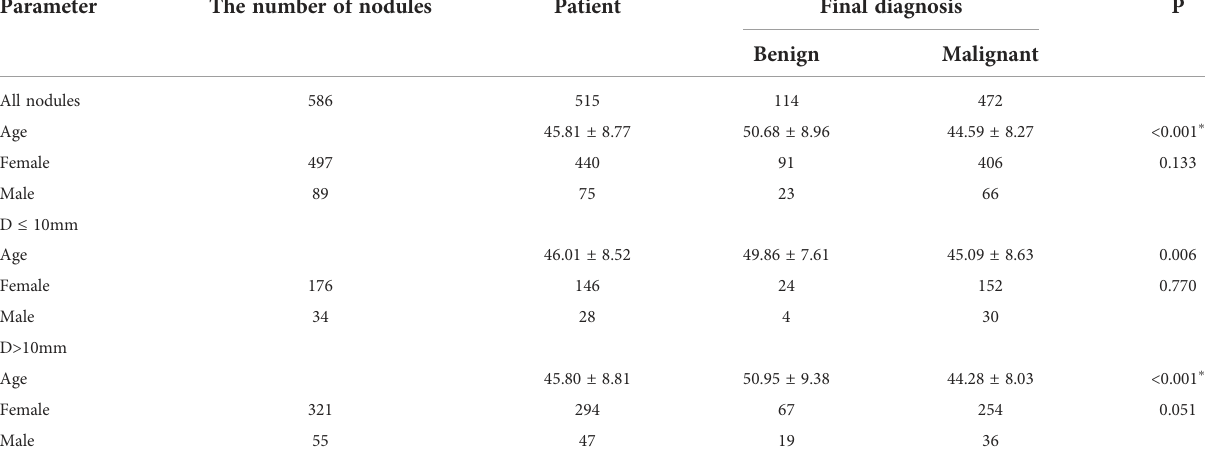
TABLE 1 Size, number of nodules and age of patients.